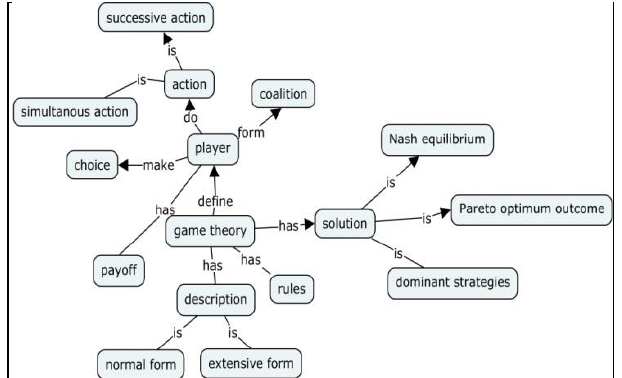
Figure 2. An extract of the proposed PGBLSs ontology of requirements